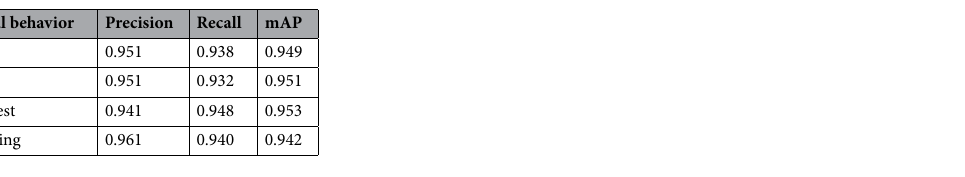
Table 3. The effect of the YOLOv5 network.